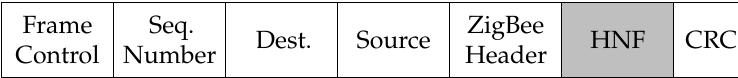
Figure 6. ZigBee packet structure with the HNF as payload.